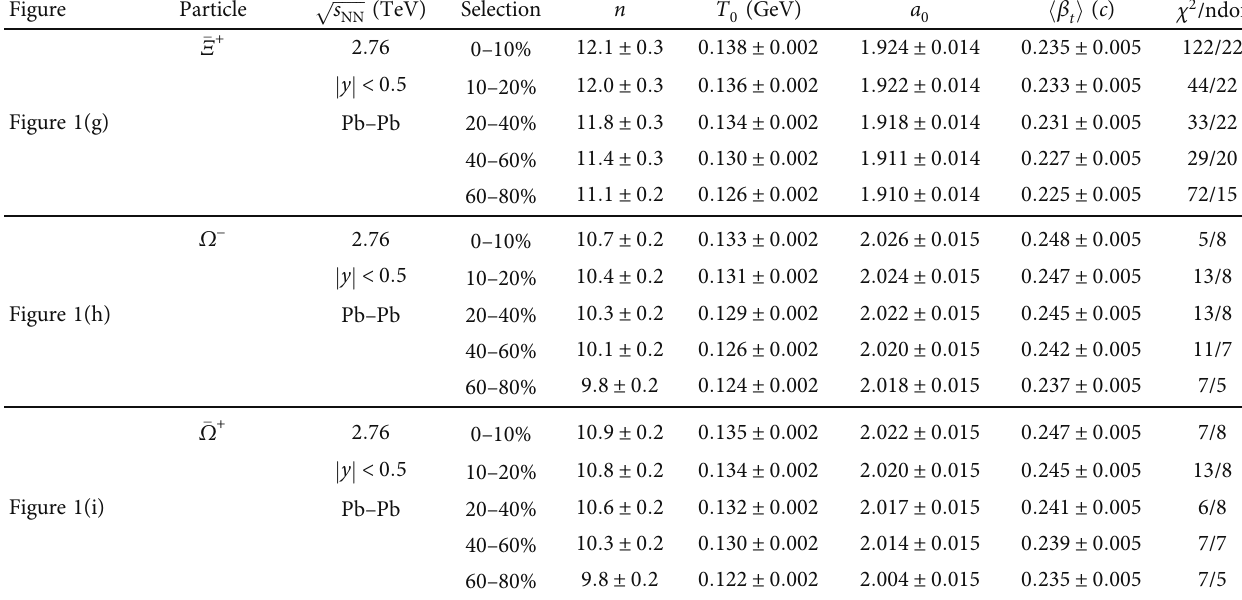
ffiffiffiffiffiffiffi s NN